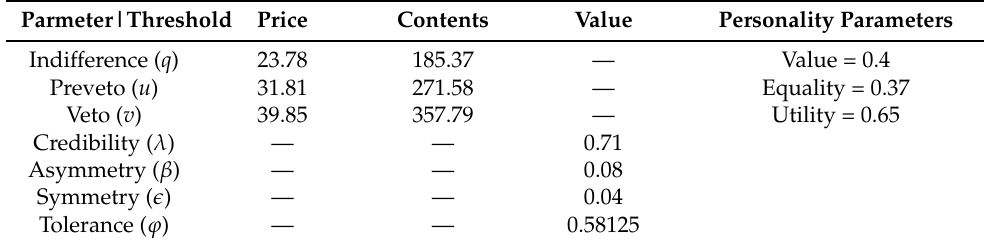
Table 2. Collaborative profile individual and its